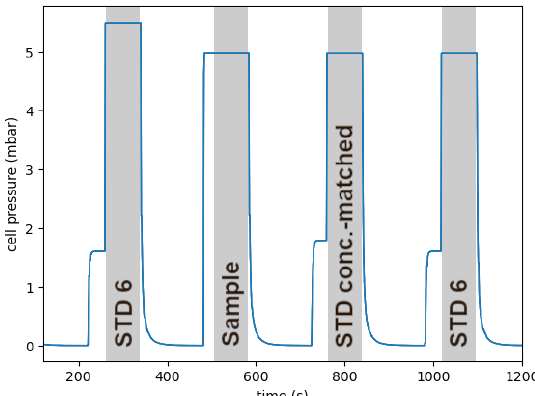
Figure 7. Measurement procedure of a single dip tube sample as recorded in the pressure time-series inside the absorption cell. The sample is flanked by several standard gases in a bracketing approach. The shaded blocks indicate measurement periods. The “shoulder” of approx. 1.7hPa before every standard gas (STD) pe- riod indicates a 30s purge to equilibrate all surfaces before the cell is filled to a specified